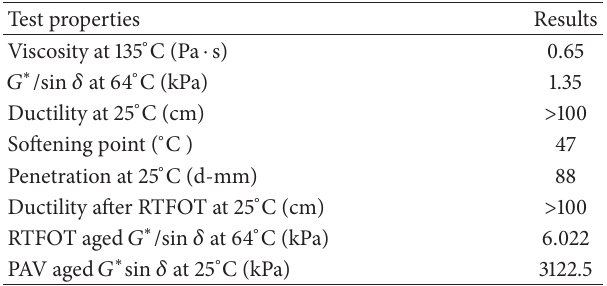
Table 1: Physical and rheological properties of 80/100PG bitumen.